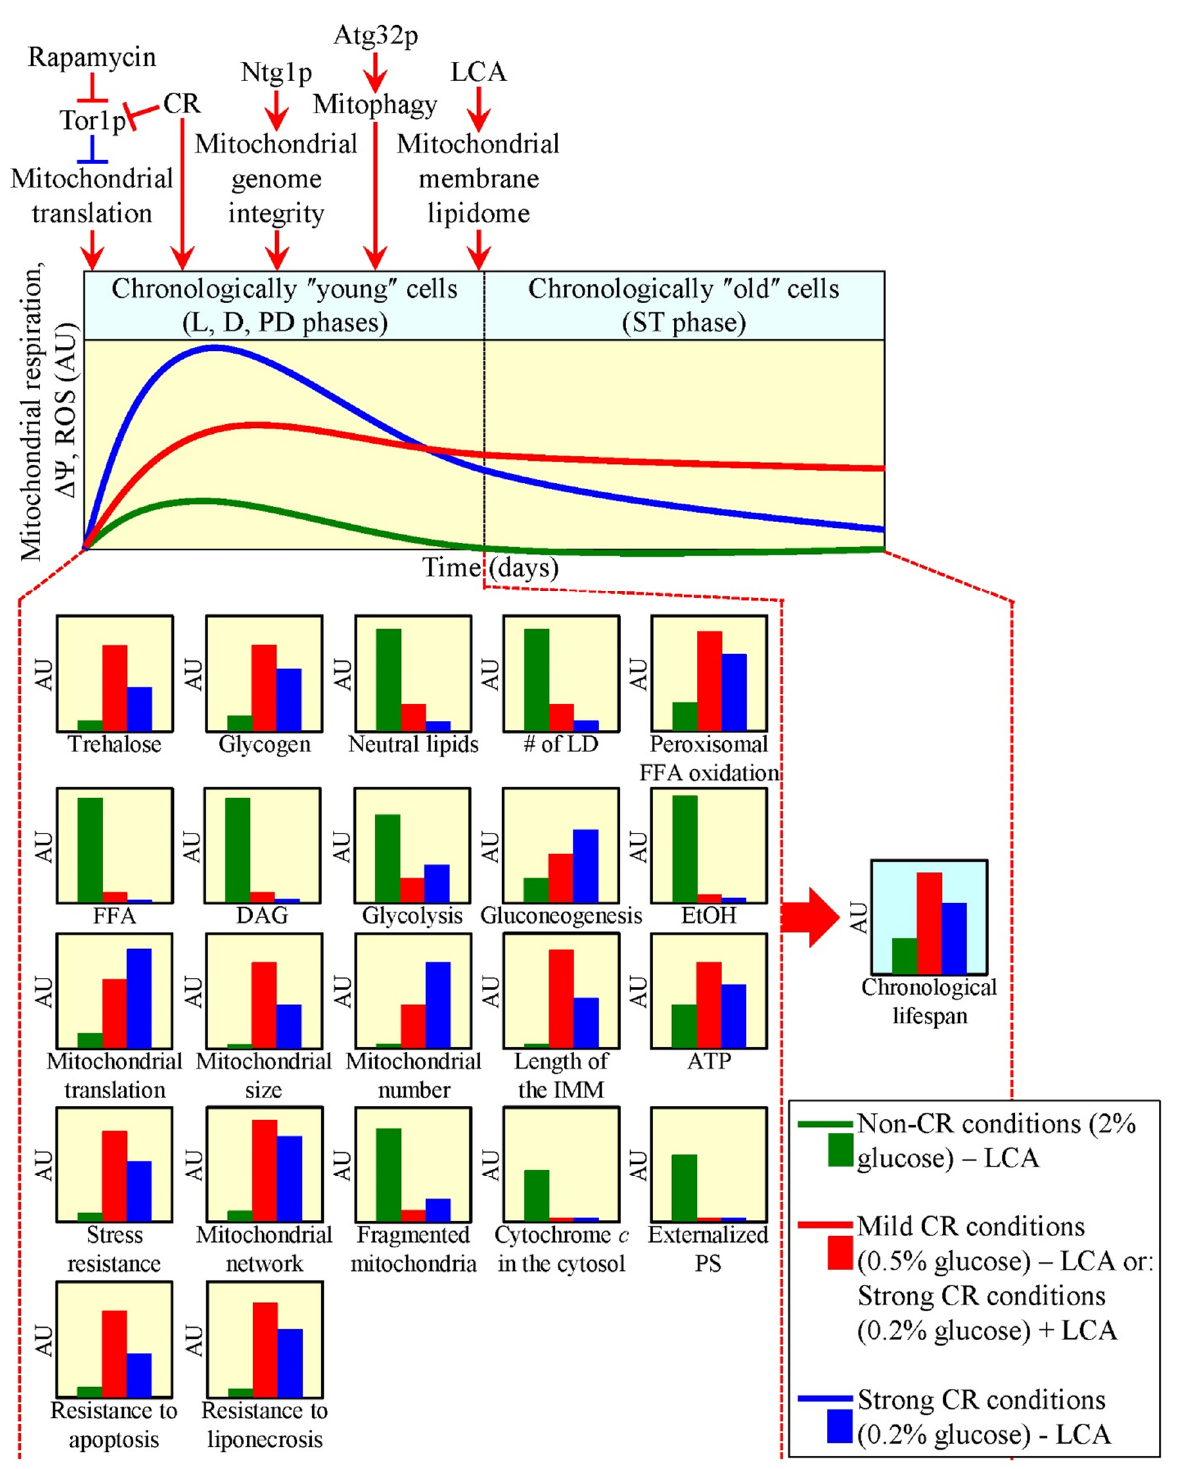
FIGURE 2: The functional state of mitochondria and mitochondrial ROS production in chronologically ″young″ yeast cells define their longevity by orchestrating numerous ″downstream″ cellular processes. A model for how coupled mitochondrial respiration, mitochondrial membrane potential maintenance and mitochondrial ROS production early in life of chronologically aging yeast cells, prior to entry into a non-proliferative state, define their viability after such entry - i.e., define their longevity. Activation arrows and inhibition bars denote pro- aging processes (displayed in blue color) or anti-aging processes (displayed in red color). Please see text for additional details. CR, caloric restriction; D, diauxic growth phase; DAG, diacylglycerol; EtOH, ethanol; FFA, non-esterified ( ″free″) faHy acids; IMM, inner mitochondrial membrane; L, logarithmic growth phase; LCA, lithocholic acid; LD, lipid droplet; PD, post-diauxic growth phase; PS, phosphatidylserine; ROS, reactive oxygen species; ST, stationary growth phase; ΔΨ m , electrochemical potential across the OPEN ACCESS | www.microbialcell.com 168 Microbial Cell | June 2014 | Vol. 1 No. 6